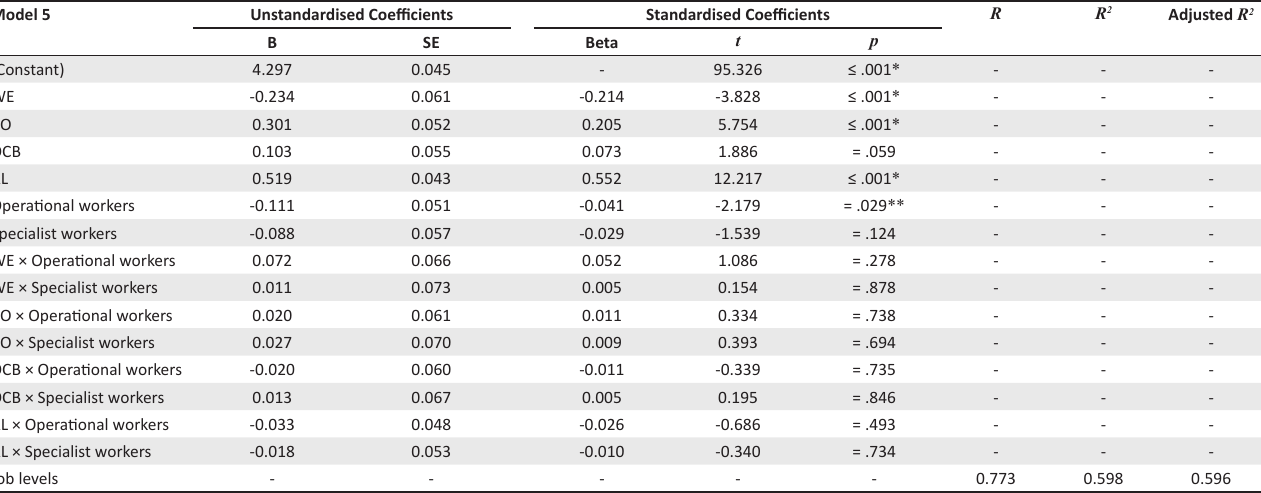
TABLE 7: Moderated multiple regression in terms of job levels.